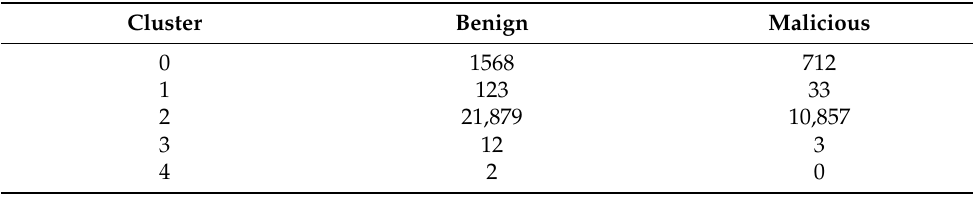
Table 7. Clustering results.